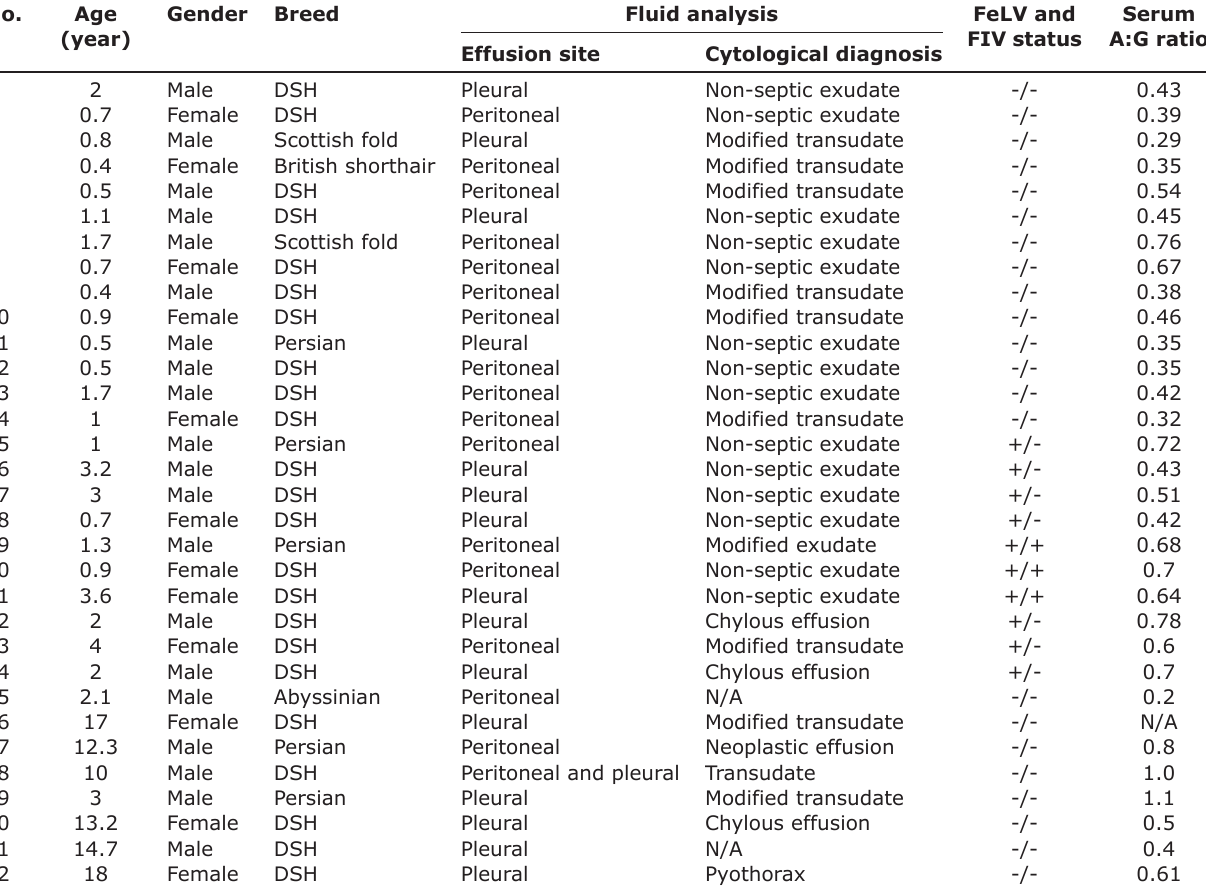
Table-1: List of 32 cats in the study, including signalments, retrovirus status, clinical effusion sites, cytological evaluation of effusions, and serum albumin-to-globulin (A:G)